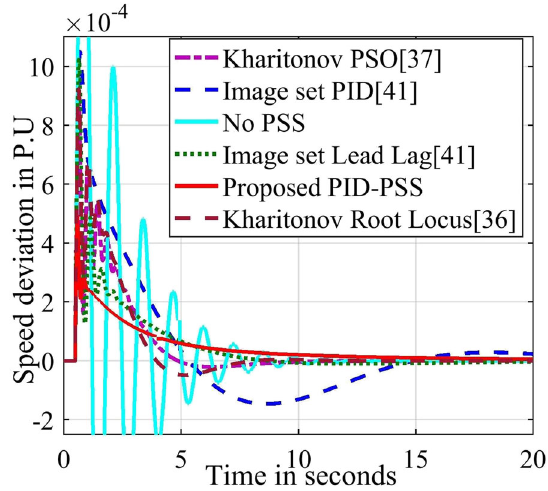
Fig. 12 Comparision of terminal voltage deviation response of the proposed with existing methods to 0.1 p.u. torque disturbance at P = 1 p.u. and Q = -0.4 p.u